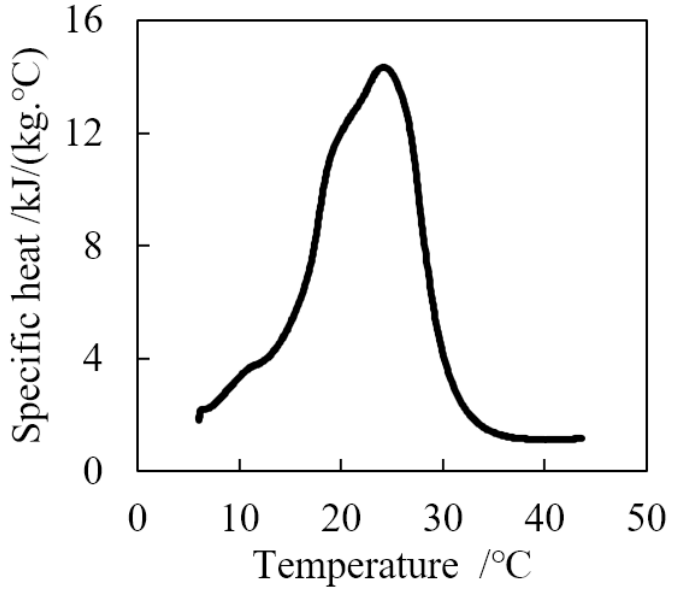
Figure 9. Equivalent specific heat of PCM. Table 2. Material physical parameters of each layer of the experimental wallboard.